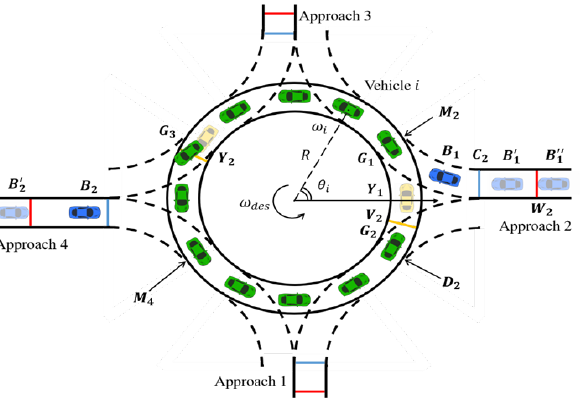
Figure 3. Illustration of self-adjusting stage and virtual platoon control stage in vehicles’ merge-in procedure.